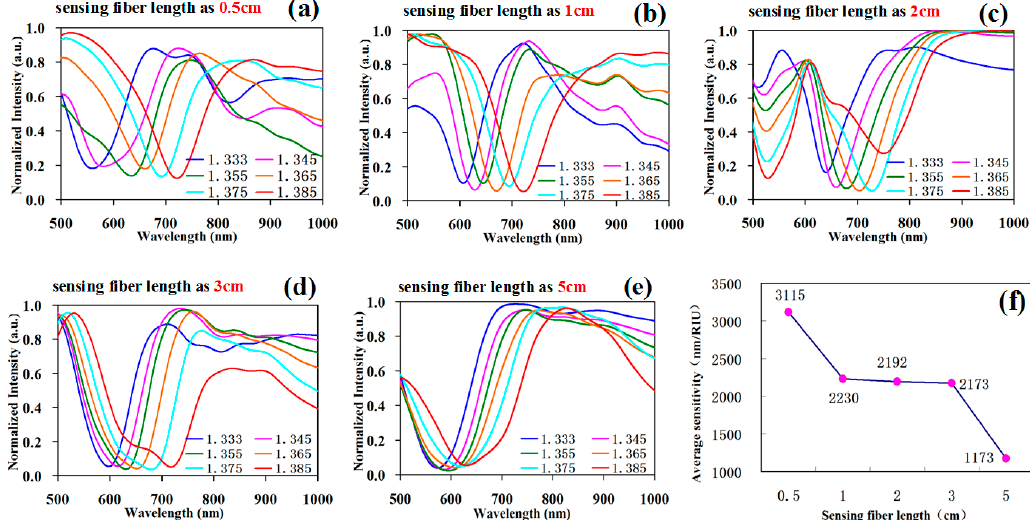
Figure 8. Renormalized sensing fiber SPR testing data with different lengths. ( a ) Normalized experimental data when the sensing fiber length was 0.5 cm; ( b ) normalized experimental data when the sensing fiber length was 1 cm; ( c ) normalized experimental data when the sensing fiber length was 2 cm; ( d ) normalized experimental data when the sensing fiber length was 3 cm; ( e ) normalized experimental data when the sensing fiber length was 5 cm; ( f ) corresponding relation diagram of sensing fiber length and sensitivity.